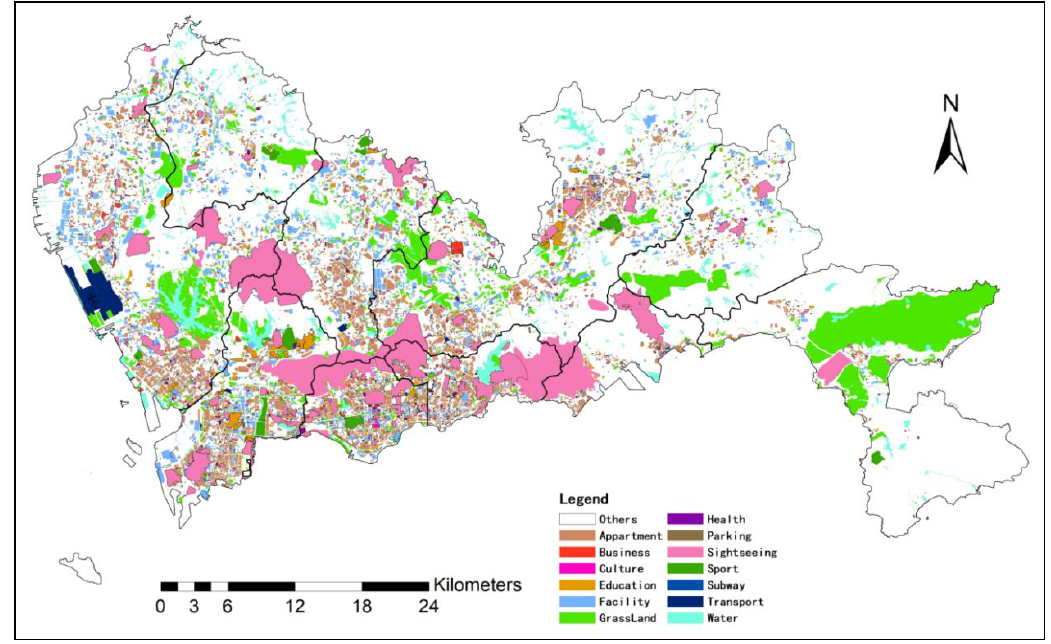
Figure 4. Land-use map in Shenzhen.